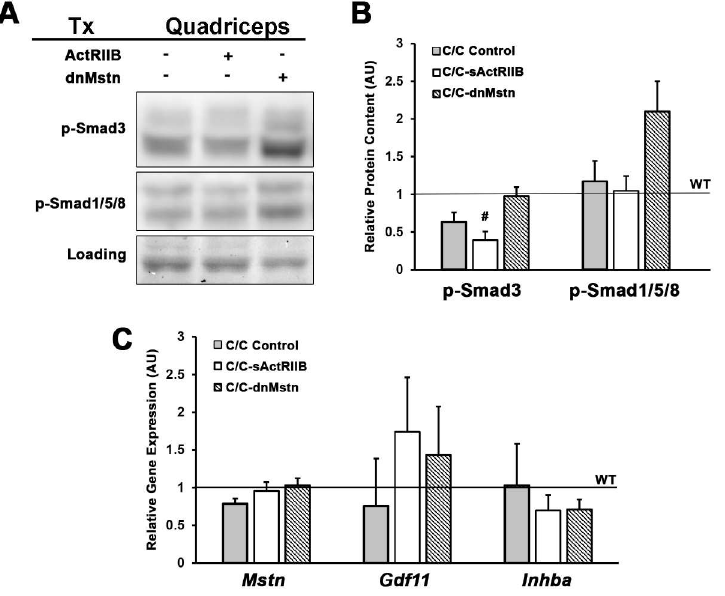
Fig 5. SMAD signaling altered by activin inhibition of SMA C/C mice. ( A-B ) Phosphorylated levels of SMAD3 and SMAD1/5/8 in quadricepslysates of 12 week-oldSMA C/C mice from control (C/C; n = 3), AAV8. LSP.sActRIIB (C/C-sActRIIB; n = 4), and AAV8.LSP.dnMstn (C/C-dnMstn; n = 4) treatment groups, normalized to Ponceau Red-visualized loadingand relativeto wild-type(WT) littermate levels. ( C ) Relative gene expressionof Mstn , Gdf11 , and Inhba (normalized to Gapdh )of 12 week-oldSMA C/C quadriceps, as measuredby real-time PCR and displayedrelative to WT levels. Data are displayedas mean ± SEM and analyzedusing one-wayANOVA (Bonferroni-Dunn post-hoc tests; # p < 0.05 vs. WT values; * p < 0.05 vs. control C/C